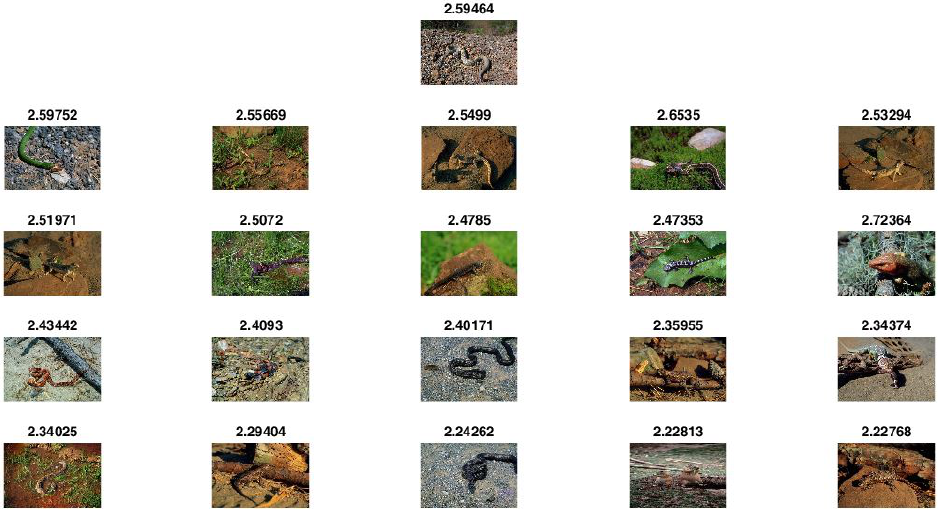
Figure 14. Result of image retrieval for the semantic class “Lizards”.